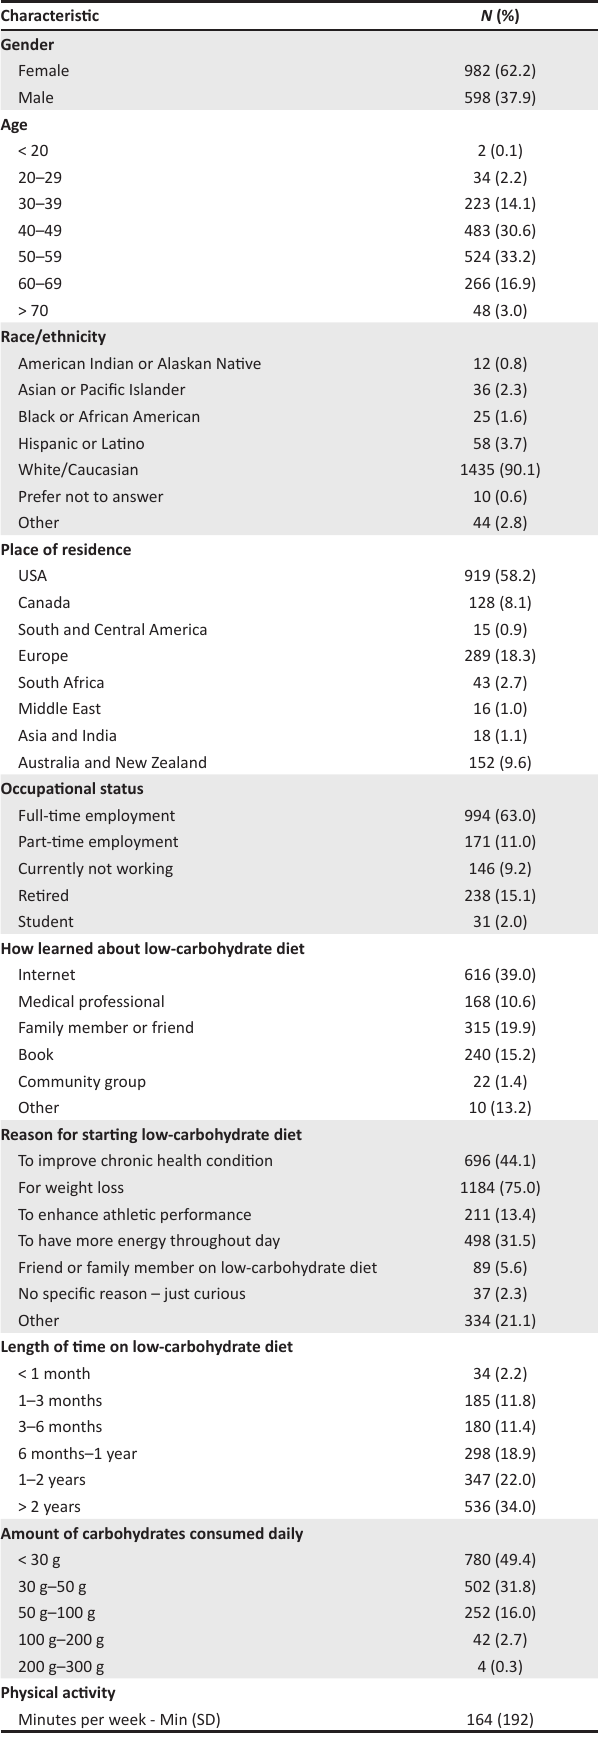
TABLE 1: Survey respondent